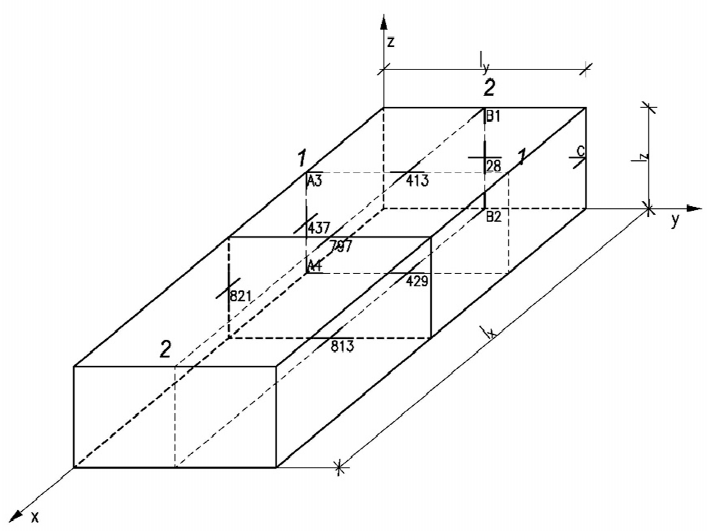
Figure 4. Schematic drawing of the tank with its internal partition with the numbering of points and cross sections.